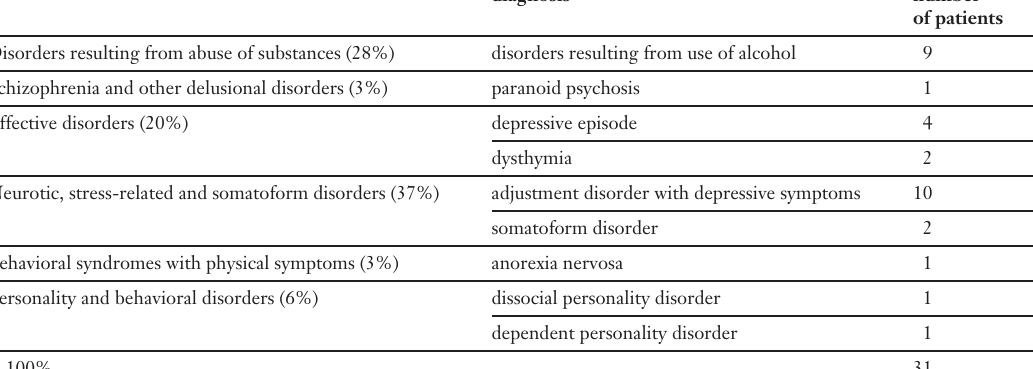
Distribution of men- tal disorders on ICD 10 Chapter F 1–6 with a severity of 2 according to Cooper’s criteria (n =